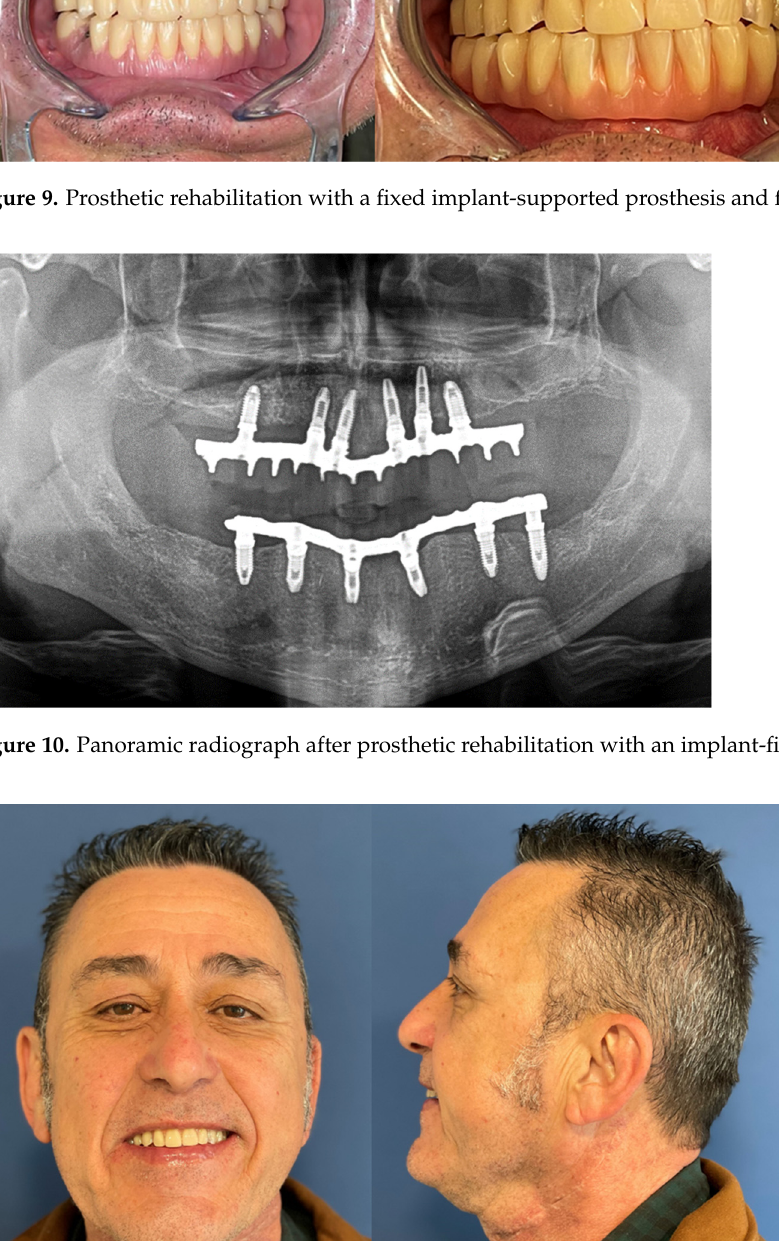
Figure 11. Aesthetic results eight months after surgery with a FAMM flap and immediate dental implants for tongue and floor of the mouth defect.